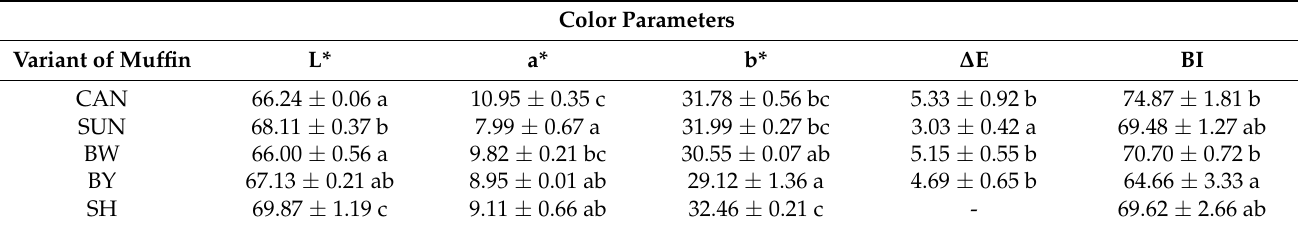
Table 5. Color parameters of muffin crust.